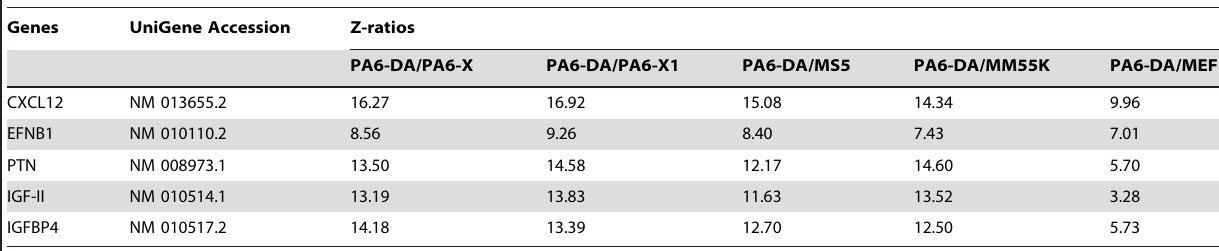
Table 2. Relative expression of the five candidate genes.